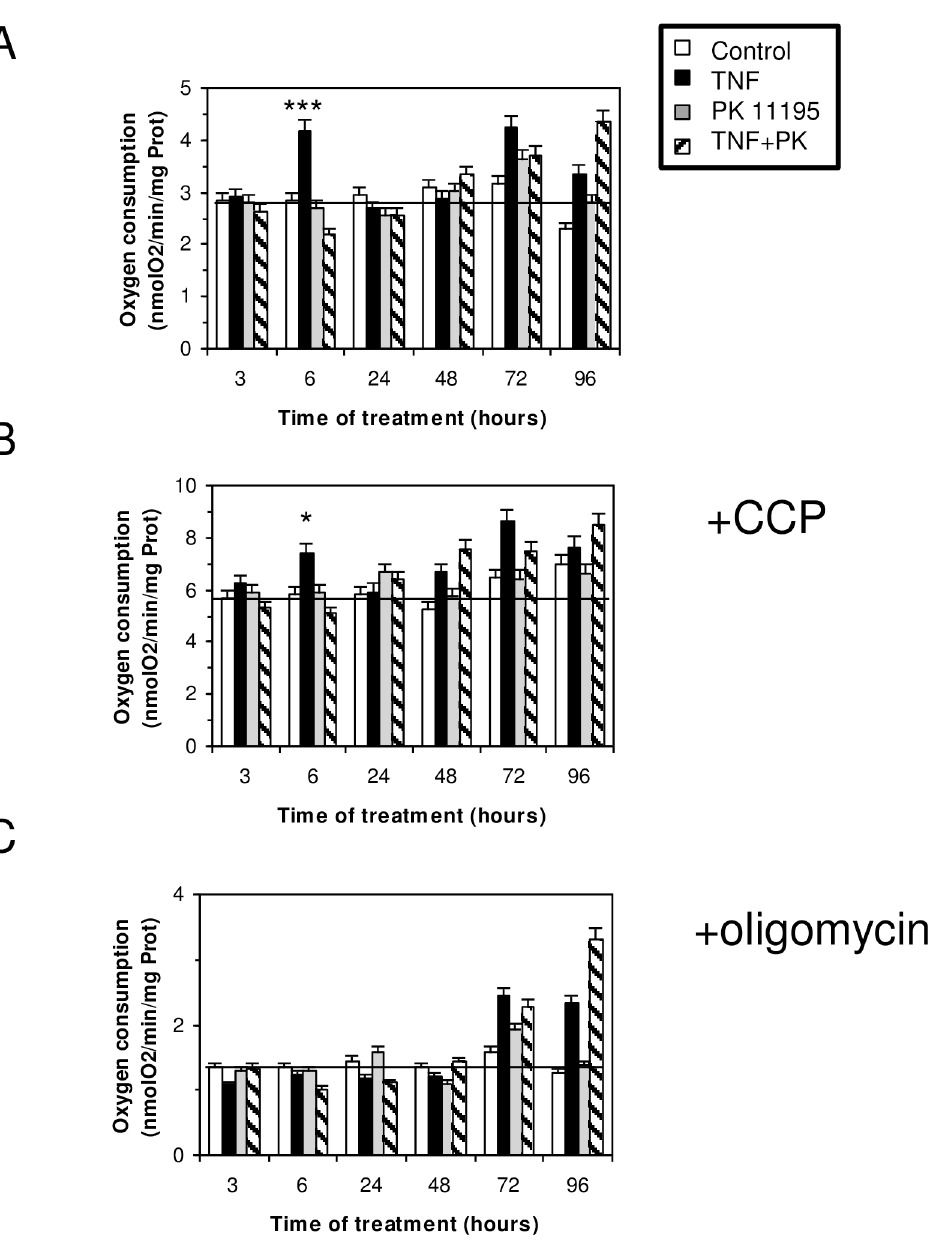
Fig 4. HT-29 cells ’ oxygen consumption after different incubation times with 10 ng/mL of TNF. (A) Oxygen consumption in control cells (open bars), in TNF-treated cells (black bars), in 1 μ M of PK 11195-treated cells (grey bars), and in cells treated simultaneously with 10 ng/mL of TNF and 1 μ M of PK 11195 (dashed bars). (B) Oxygen consumption in the presence of 1 μ M of m -Cl-CCP, a respiratory chain uncoupler. (C) Oxygen consumption in the presence of 10 μ M of oligomycin, an ATP synthase